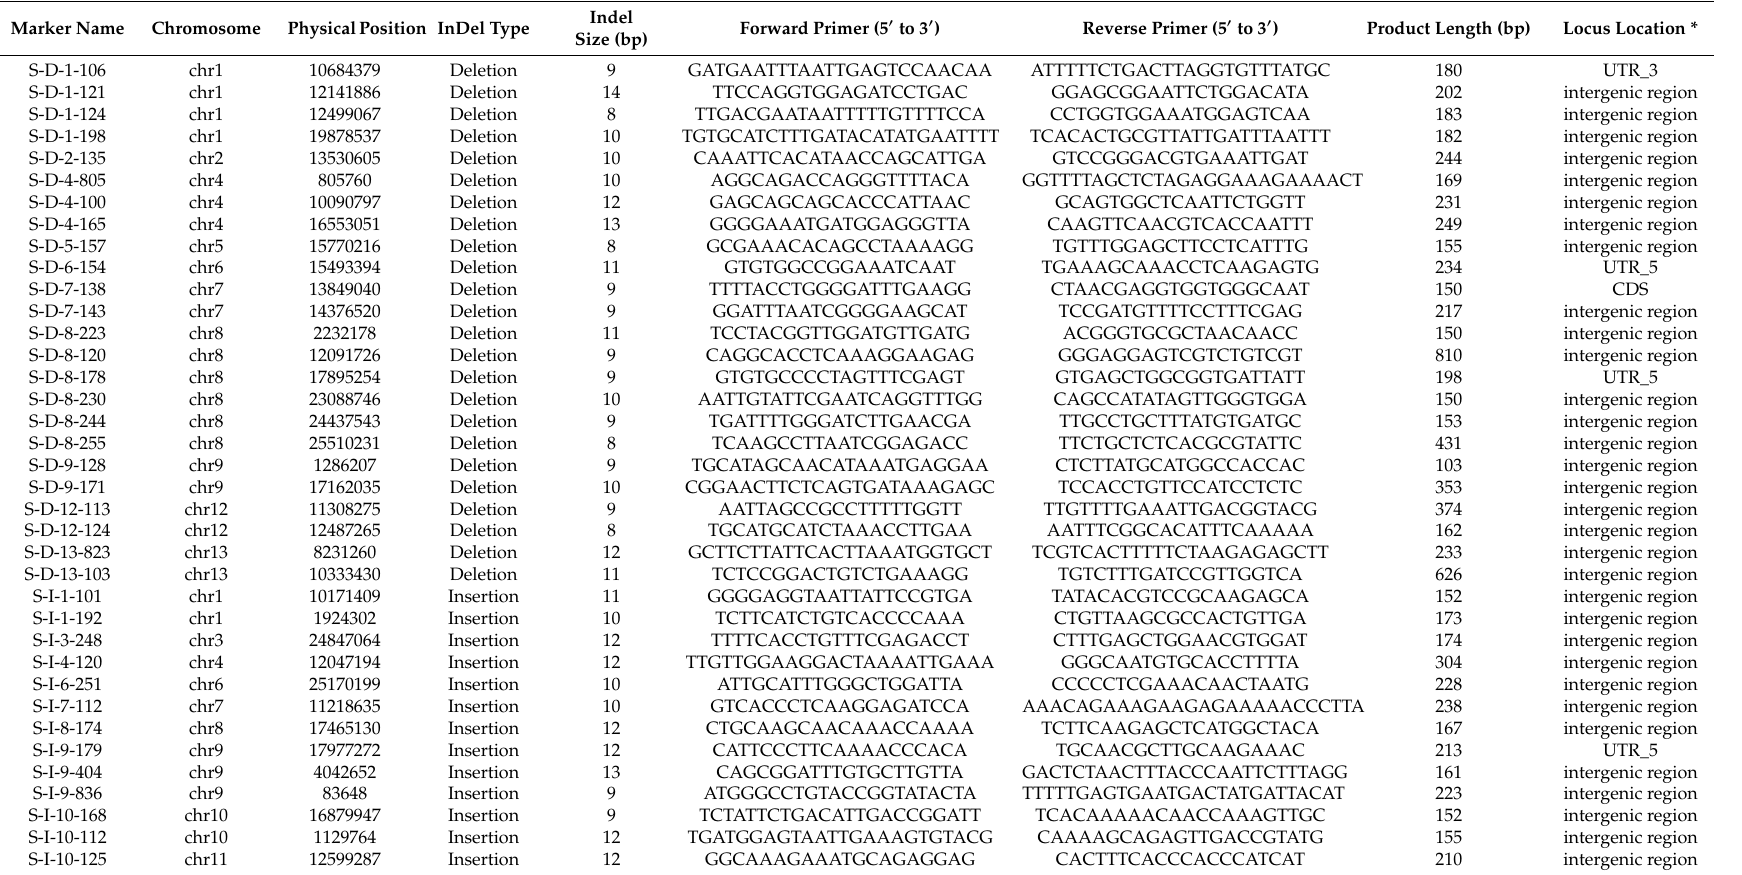
Table 6. The primer sequences of the 38 InDel markers developed and used in this